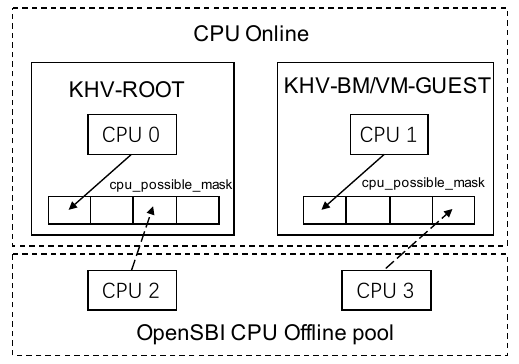
Figure 9. CPU online and offline diagram (KVM vs. KHV).